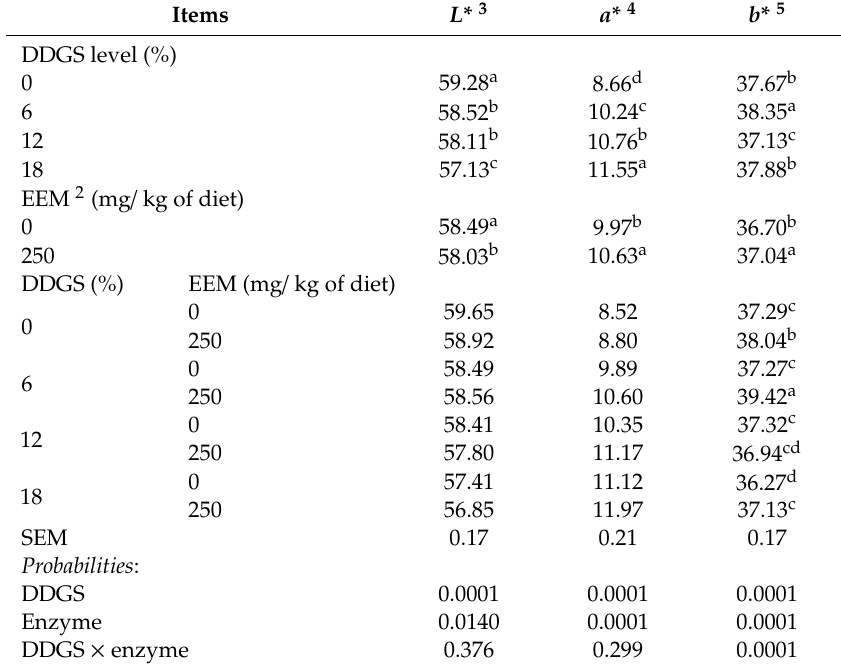
Table 4. Yolk color of laying hens organized by DDGS 1 inclusion levels and enzyme supplementation Table 32–42 weeks of age.